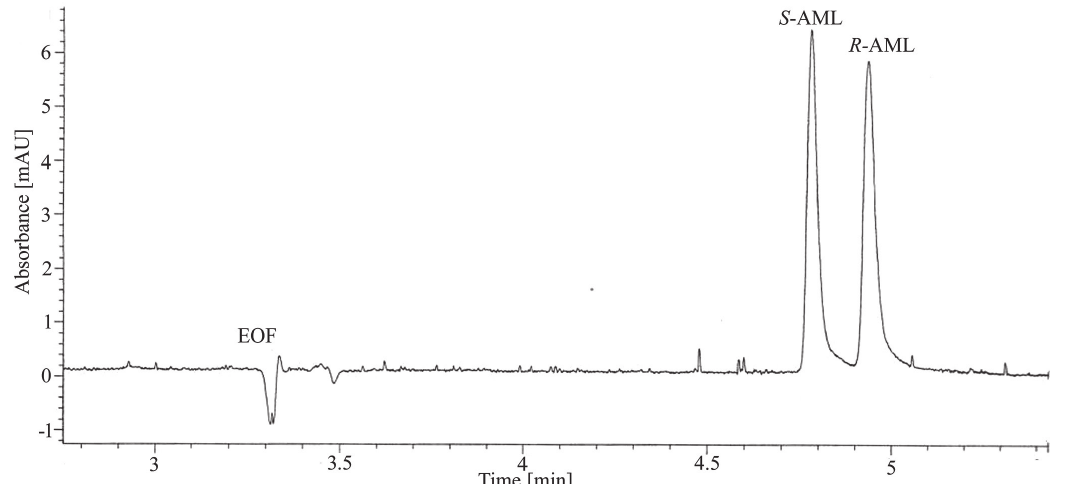
FIGURE 2 - The effects of CD concentration and BGE pH on the chiral resolution of AML enantiomers.